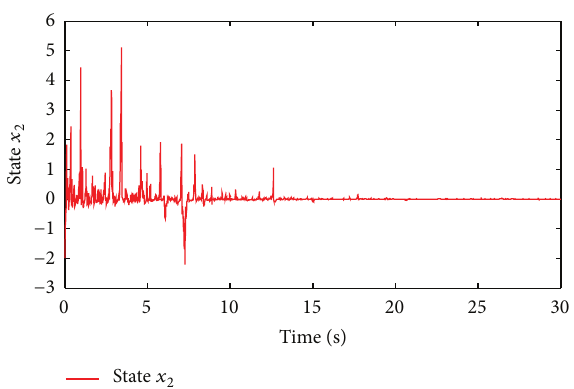
Figure 3: State x 2 of the closed-loop system.